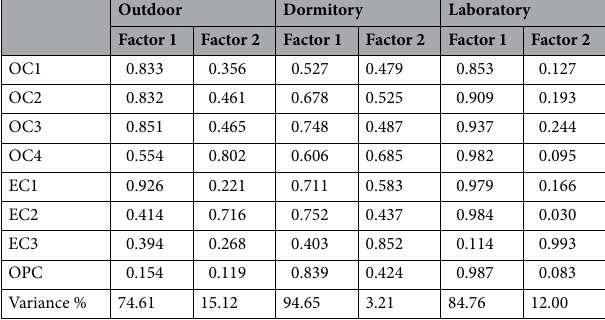
Table 4. Factor analysis of the carbon component in indoor and outdoor samples.